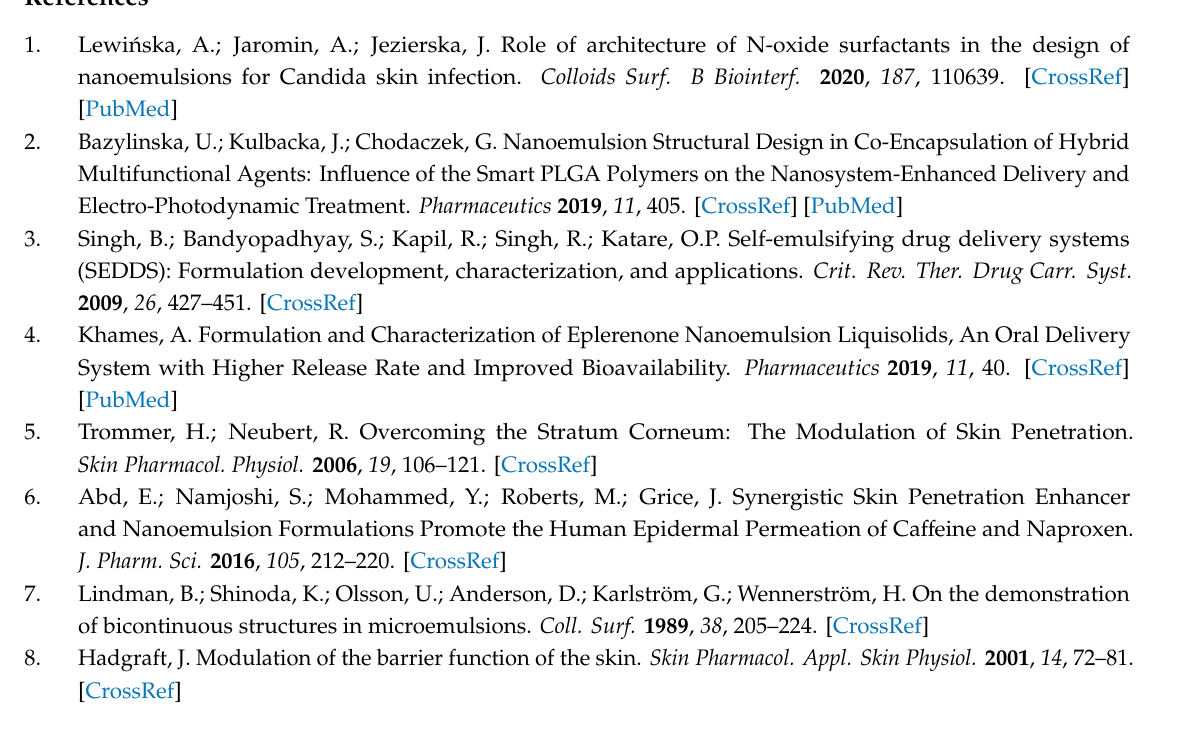
Figure S1: Analytical chromatogram of surfactin standard (up) and cultivation sample (down). Figure S2: ESI-MS of cultivation sample. All the ions have a sodium ion [M + Na] + . Figure S3: Phase diagram of Capmul MCM C8, surfactin and Transcutol HP. Figure S4: Size distribution of nanoemulsion with tocopherol (A) after preparation and (B) after 195 days; nanoemulsion with ascorbyl tetraisopalmitate (C) after preparation and (D) after 195 days. Figure S5: Size distribution of nanoemulsion with di ff erent oil phases: (a) oleic acid, (b) Limanthes alba (Meadowfoam) seed oil, (c) tocopherol in Helianthus annuus oil, (d) Cananga oil, (e) Listea cubeba fruit oil, (f) organic buckwheat oil, (g) carrot seed oil organic, (h) chaulmoogra oil organic, (i) tocopherol, (j) pressed tamanu oil, (k) pressed avocado oil, (l) pressed pomegranate oil, (m) ascorbyl tetraisopalmitate, (n) Passilflora incarnata seed oil, (o) rapeseed oil, (p) sea bucktorn pulp oil, (r) fatty acid ethyl esters, and (s) capryloyl glycine. Table S1: Surfactin isoform contents in both standard and cultivation samples, showing area under the curve (AUC) values, absolute units, and retention times in minutes. Table S2: Molecular mass, formula and quasimolecular ions of surfactin analogs. Table S3: DLS analysis for di ff erent oil phases in the designed